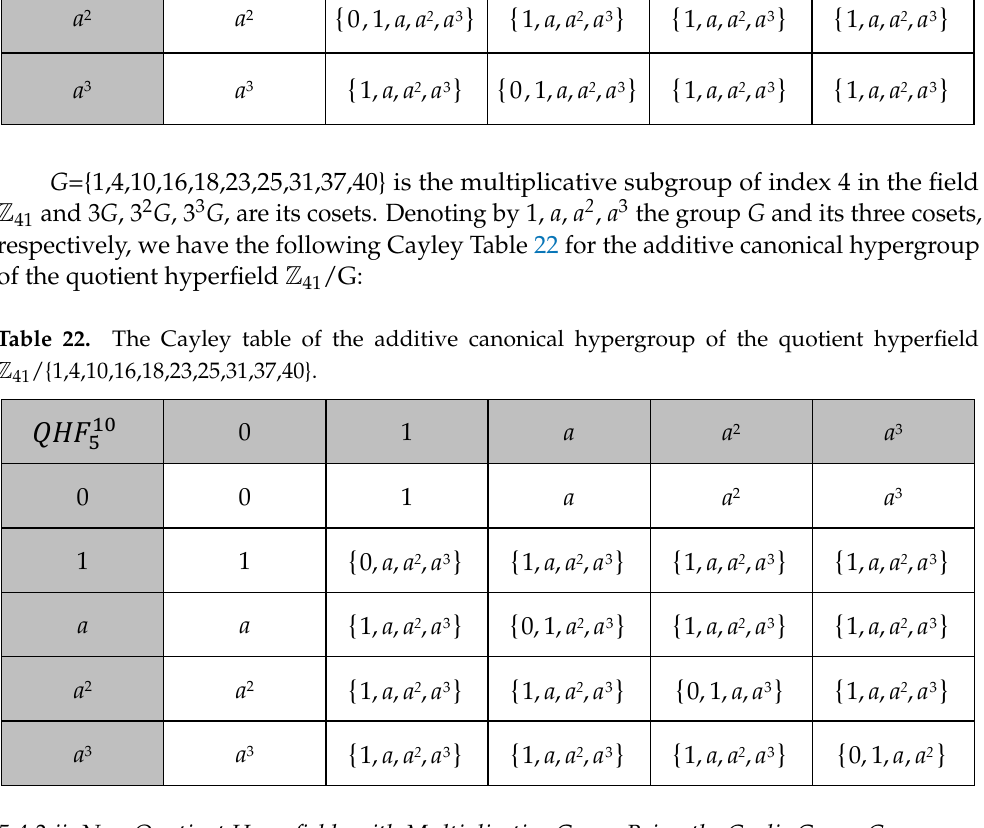
Table 23. The Cayley table of the additive canonical hypergroup of the non-quotient hyperfield constructed via Theorem